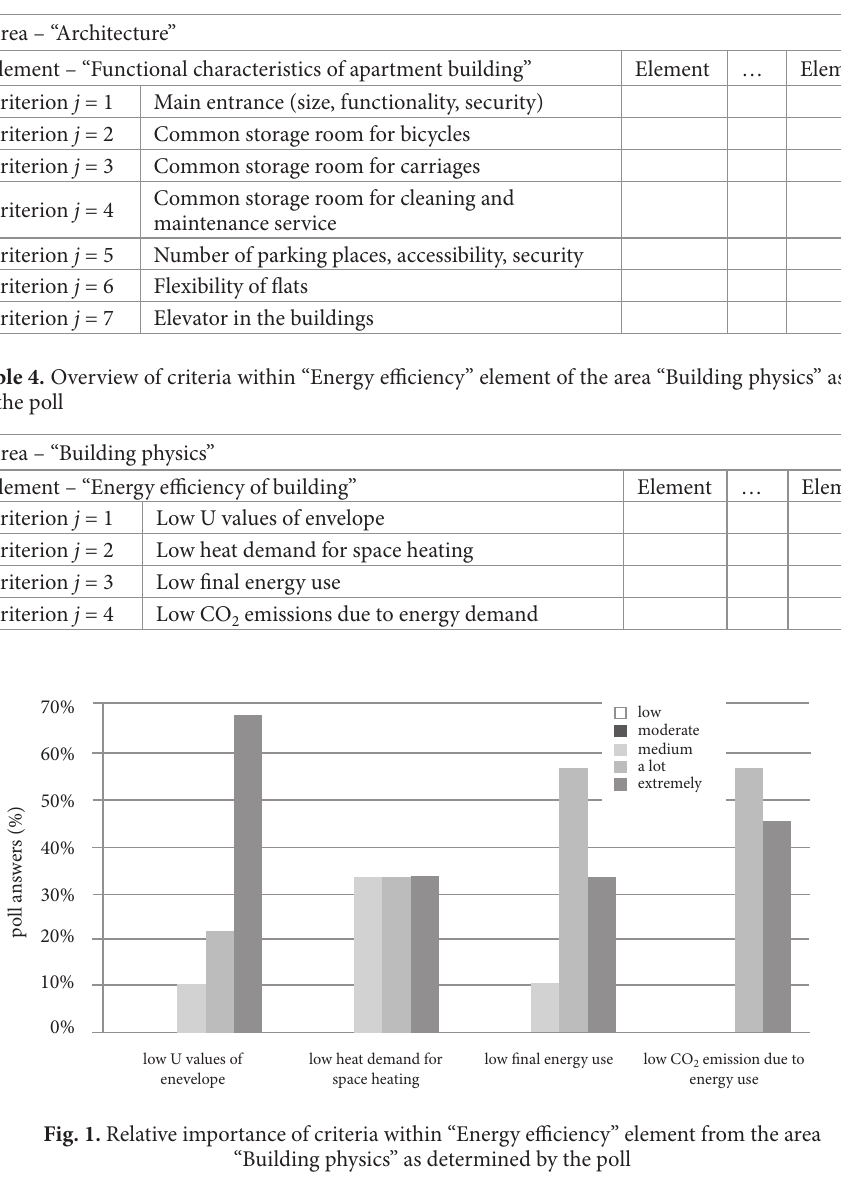
Table 3. Overview of criteria within “Functional characteristics of apartment building” element of the